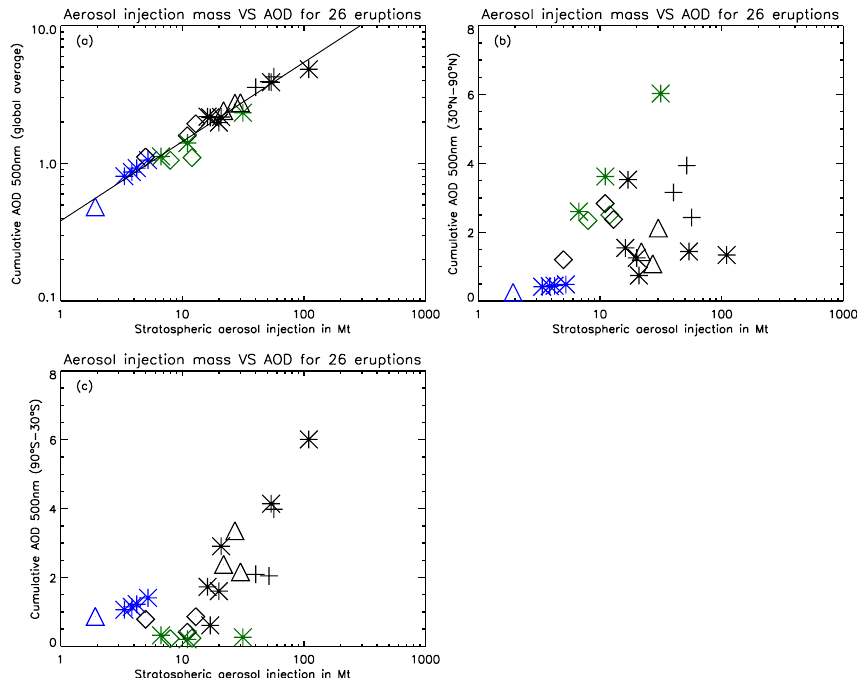
Fig. 2. Total mass of aerosol (H 2 SO 4 +H 2 O) in Mt versus 2 yr cumulated AOD at 550nm for global average (a) , 30 ◦ N–90 ◦ N (b) and 90 ◦ S–30 ◦ S (c) . Black line shows the logarithmic fit to the tropical eruptions. Stars indicate spring eruptions, triangles summer eruptions, di- amonds fall eruptions and crosses winter eruptions. Black color indicates tropical eruptions, while blue and green colors indicate extratropical eruptions in the Southern and Northern Hemispheres